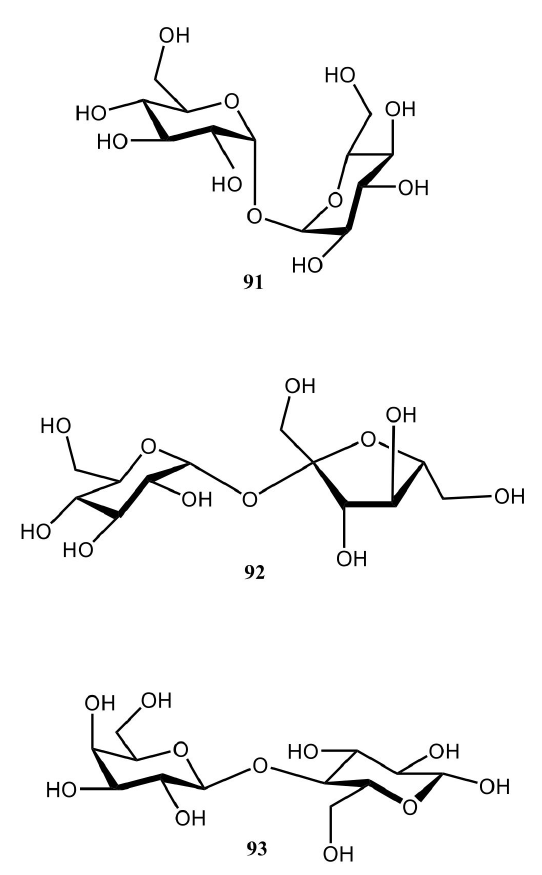
Figure 47. Chemical structures of three classical disaccharides, trehalose ( 91 ), sucrose ( 92 ), and lactose ( 93